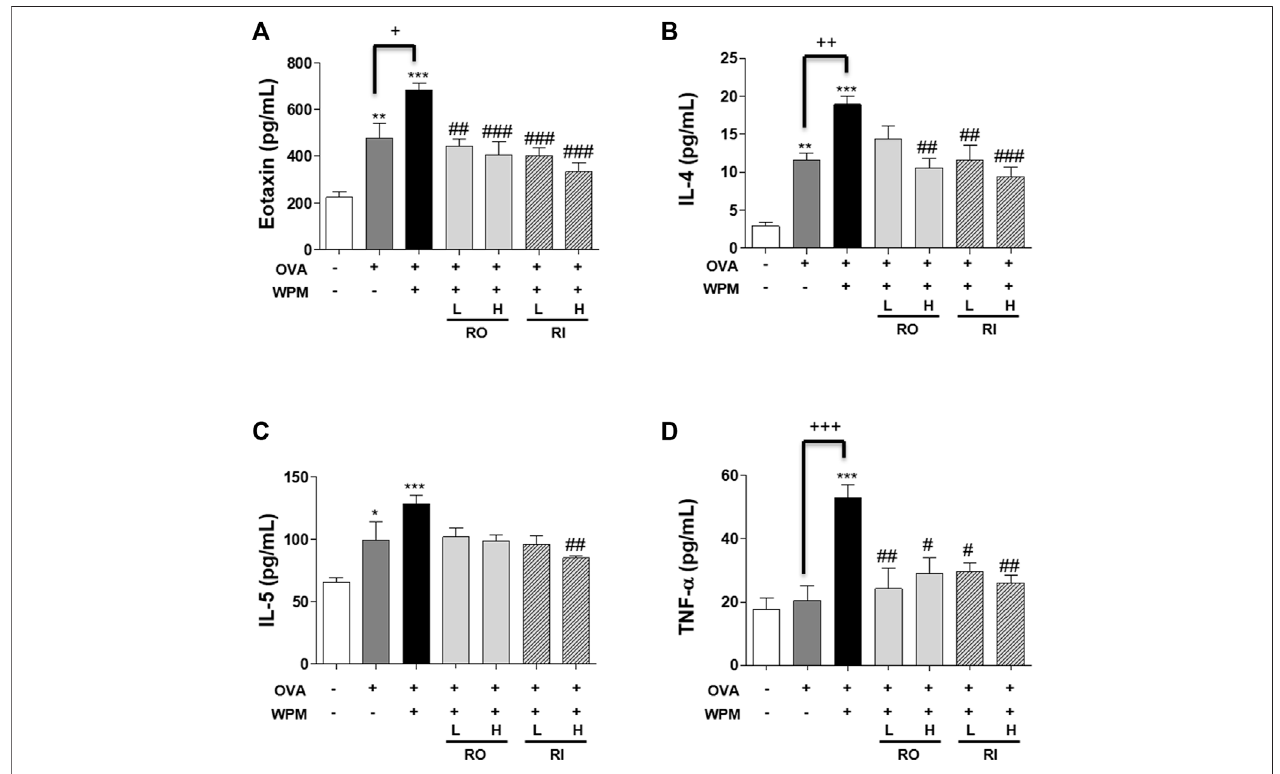
FIGURE5| TheeffectsofRLonthecytokineandchemokinelevelsinaWPM-exacerbatedmousemodelofasthma.Thelevelsof (A) Eotaxin, (B) IL-4, (C) IL-5and (D) TNF- α wereanalyzed using aMultiplex ELISAkit. Alldataarepresentedasthemean±SEM. n =5/group. * p < 0.05, ** p < 0.005and *** p < 0.001compared withthe controlgroup; # p < 0.05, ## p < 0.005 and ### p < 0.001compared with theOVA + WPM group; + p < 0.05, ++ p < 0.005 and +++ p < 0.001 compared with theOVA group.